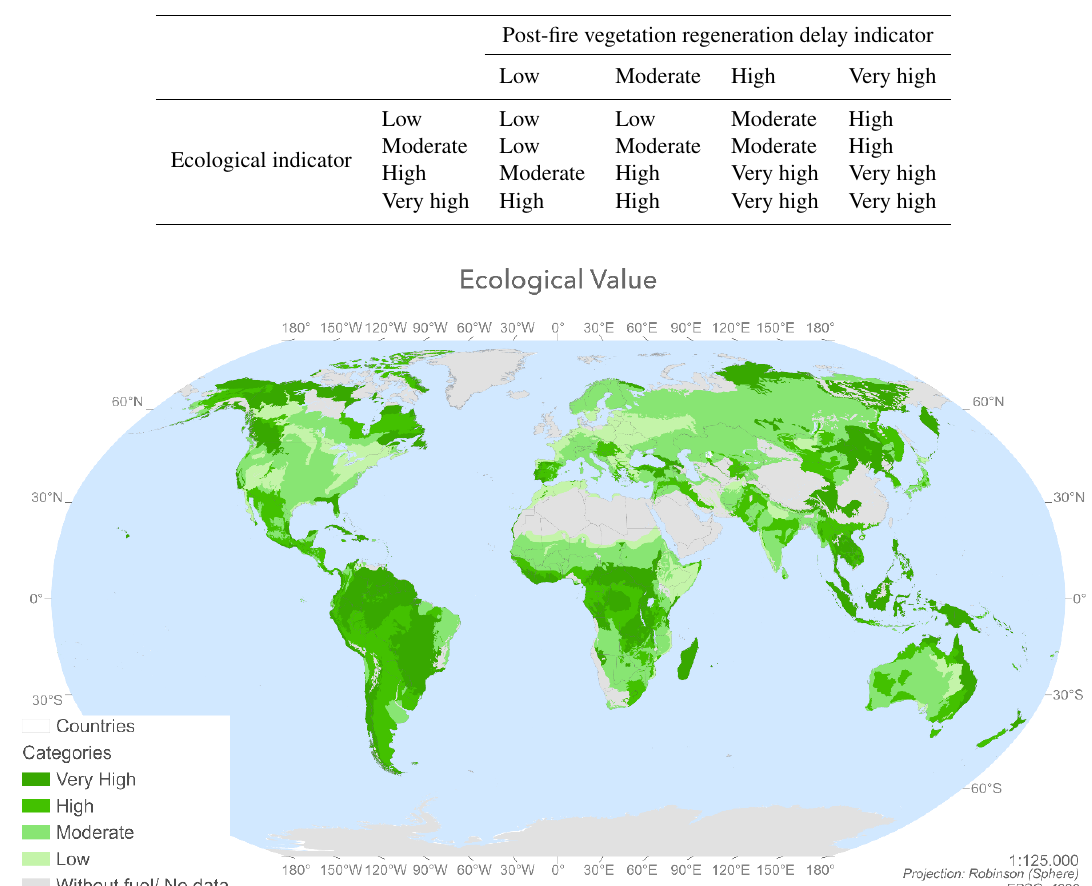
Table 9. Criteria for assigning ecoregions to the different ecological vulnerability index categories.